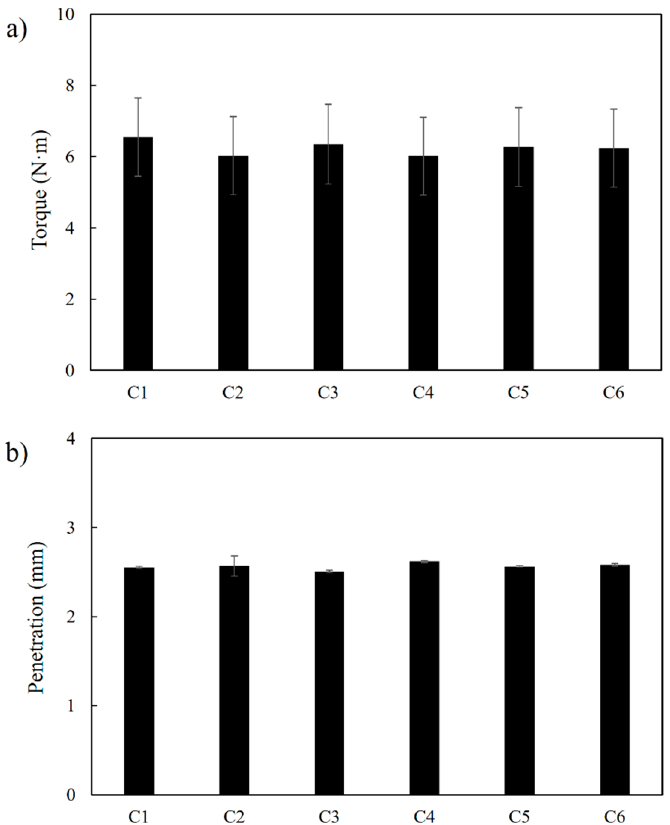
Figure 4. ( a ) Torque and ( b ) penetration average values obtained during the friction stir welding (FSW) process for C1–C6 coupons.